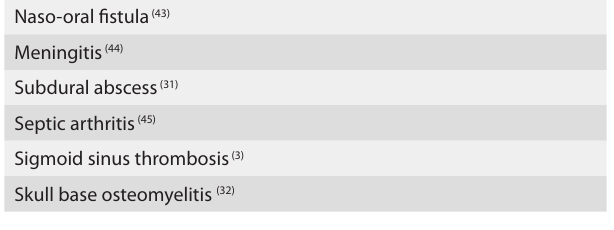
Table 3. Reported complications of